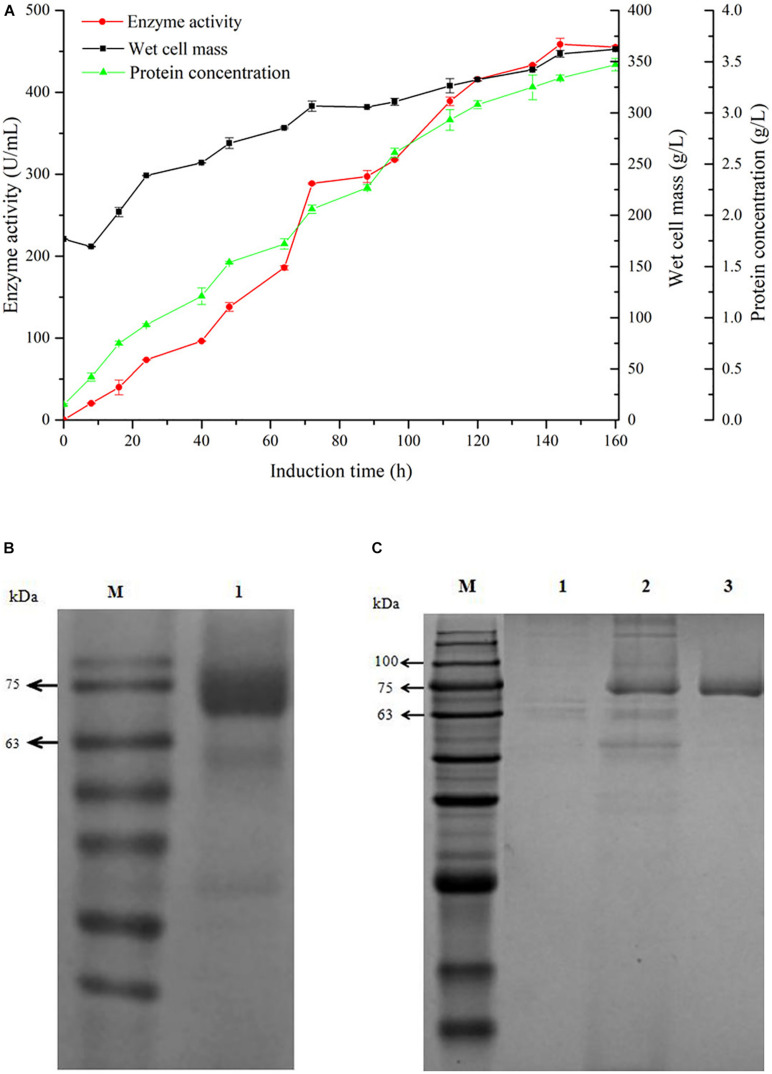
Time-course of GOxP5 in 20 L fermenter (A) and SDS-PAGE analysis (B) of recombinant glucose oxidase. The enzyme activity (•), wet cell mass (■), protein concentration (▲) were measured during high-cell-density fermentation. Line M, protein marker; line 1, purified GOxP5 fermentation supernatant withdrawn at 120 h after methanol induction. The supernatant samples after 96 h fermentation in shake flask of control strain pPICZα A/X33(line 1), the crude cell extract (line 2), and purified GOxP5 (line 3) were displayed by SDS-PAGE (C).